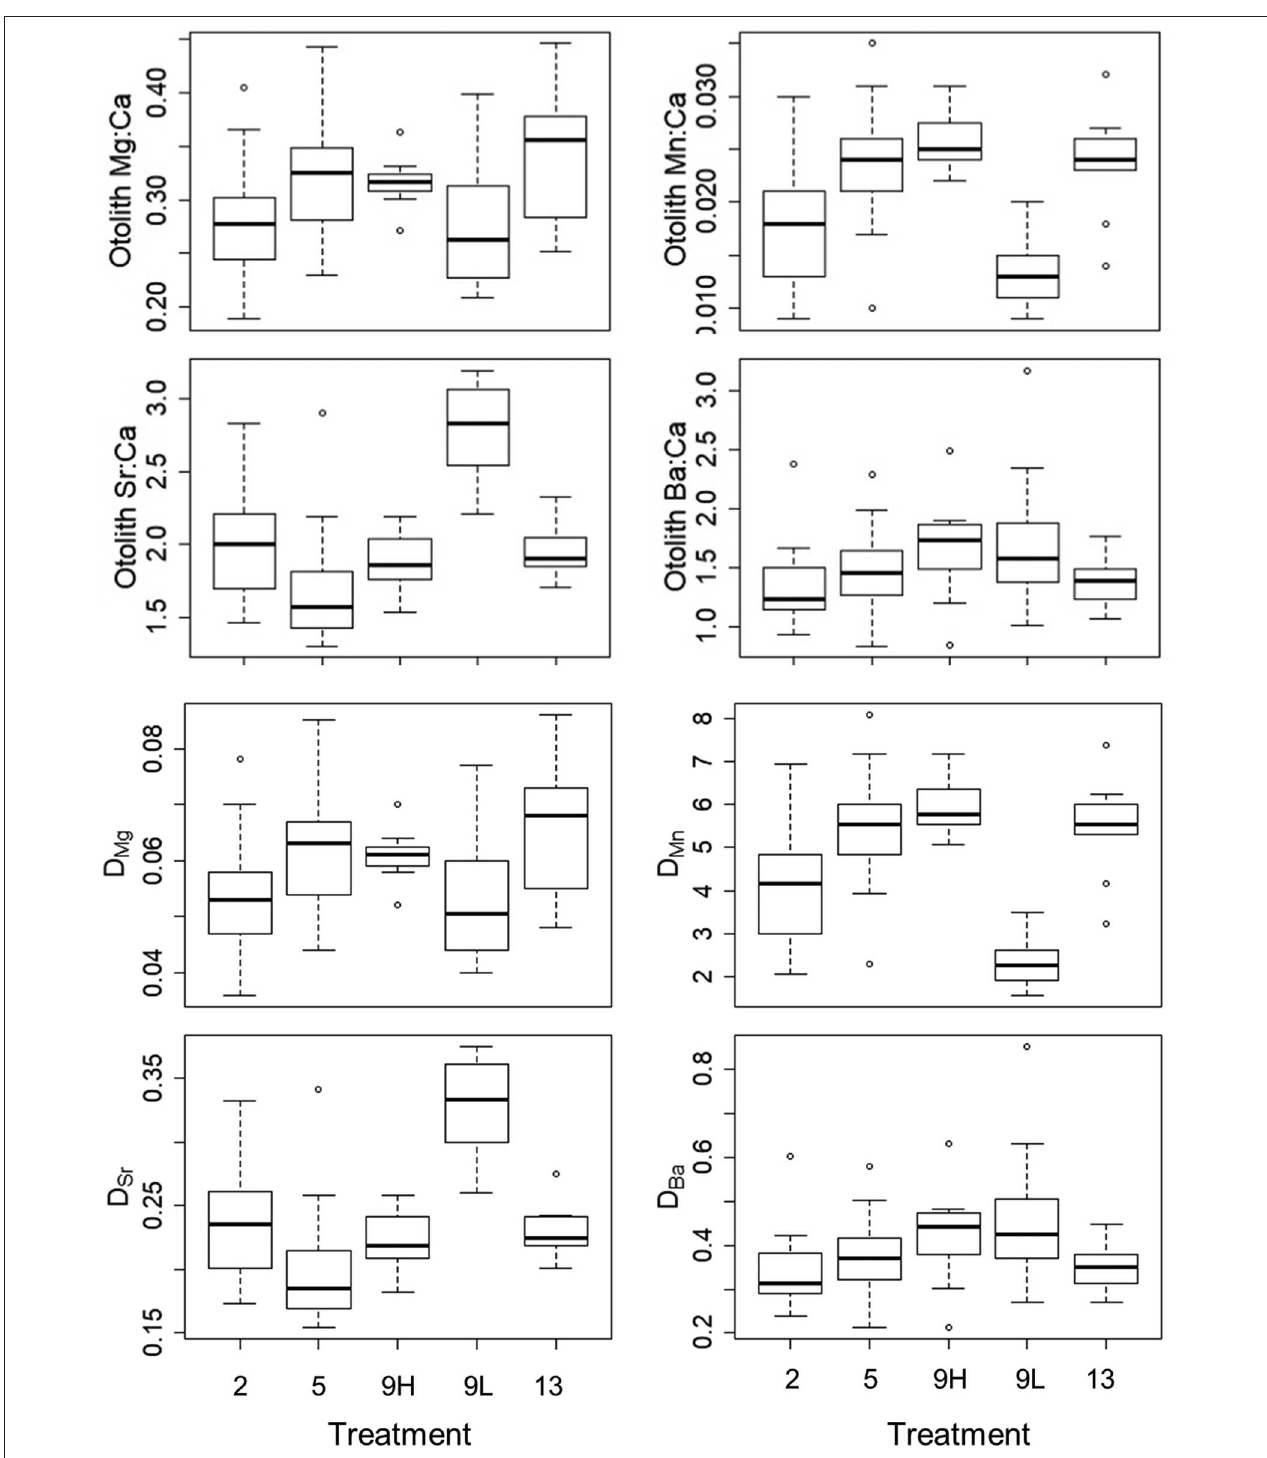
FIGURE 3 | Median, first, and third quartiles and outlying points for otolith Me:Ca (upper four graphs) and D Me (lower four graphs) for the 2, 5, 9_low ration (9L), 9_high ration (9H), and 13 ◦ C treatments. the effect of growth rate within temperature treatments although effect for Mg ( + ), and no effect for Ba. Temperature effects were the observed directionality of the potential growth effects were only observed for D Mn and D Mg and only associated with the 2 ◦ C similar to the ration effect for Mn and for Sr but not for treatments. Furthermore, the data were inconclusive regarding